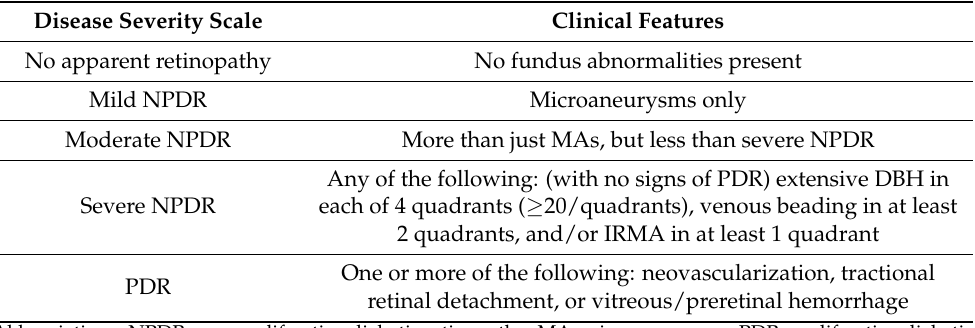
Table 1. International Clinical Diabetic Retinopathy Disease Severity Scale [37]. Disease Severity Scale Clinical Features No apparent retinopathy No fundus abnormalities present Mild NPDR Microaneurysms only Moderate